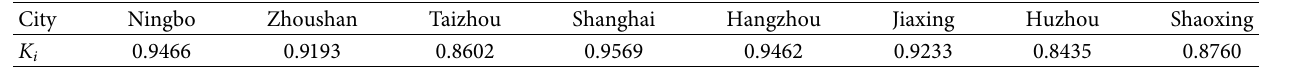
Table 3: Integrated logistics influence factor of each city in the three metropolitan areas.